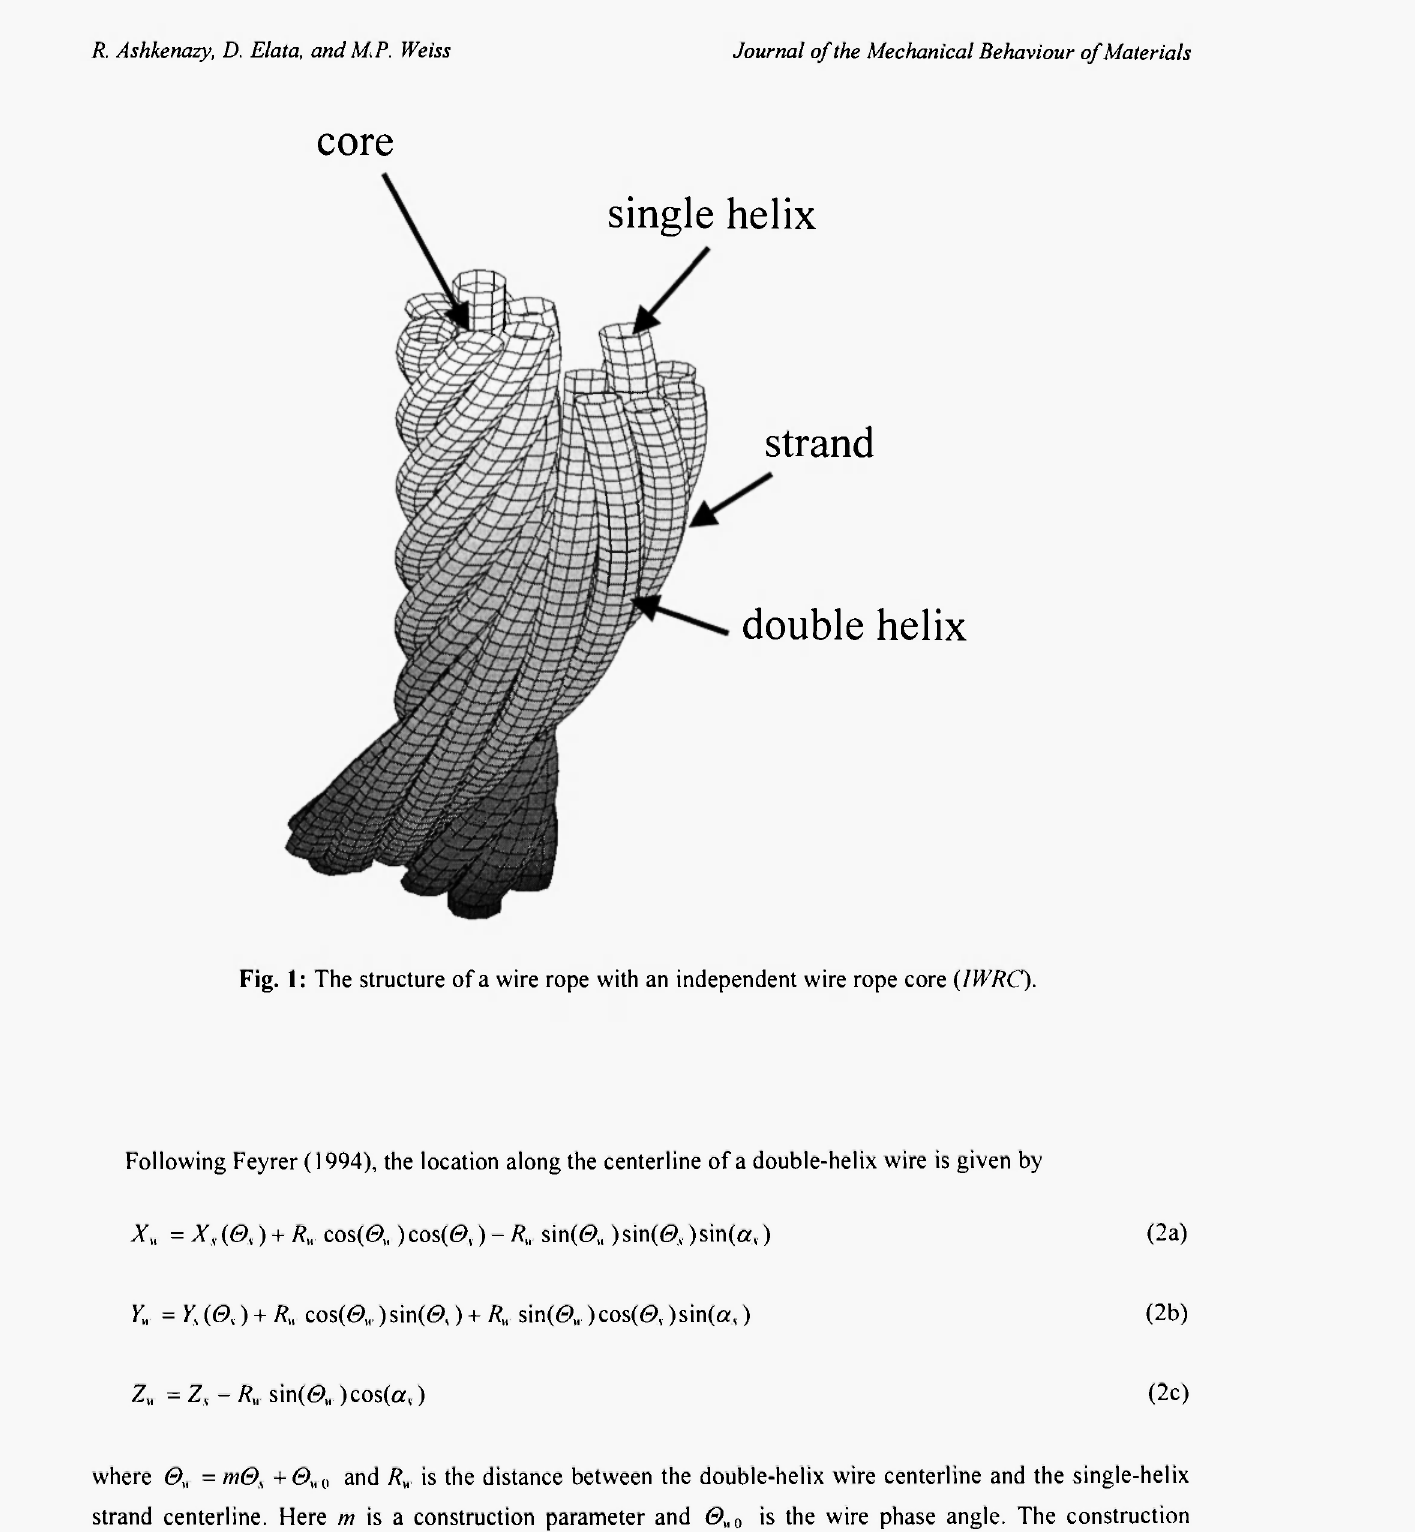
Fig. 1: The structure of a wire rope with an independent wire rope core (